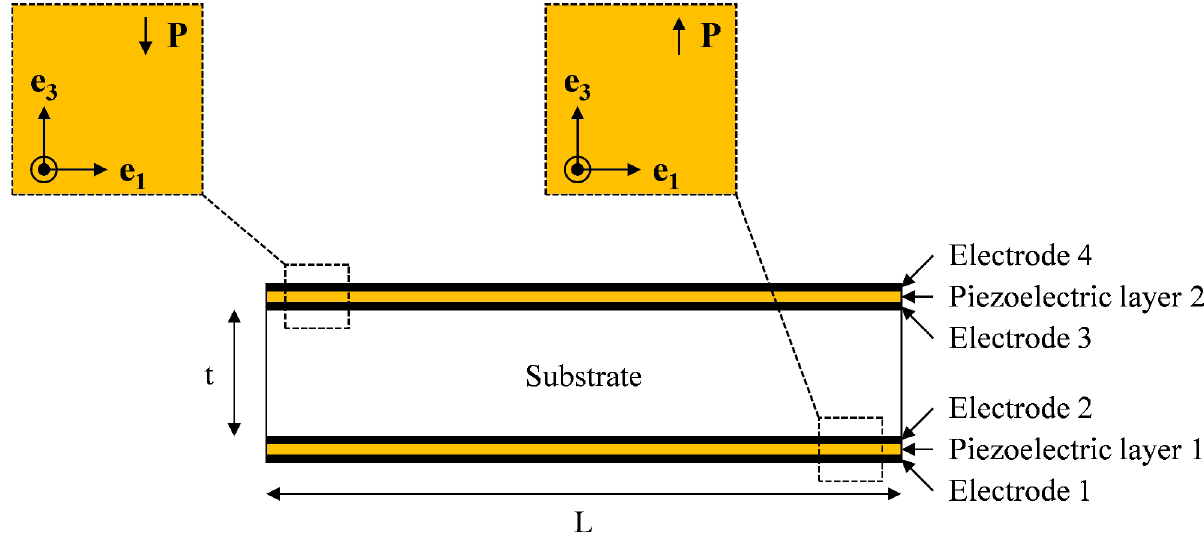
Fig. 10. Section view of a functionalized beam